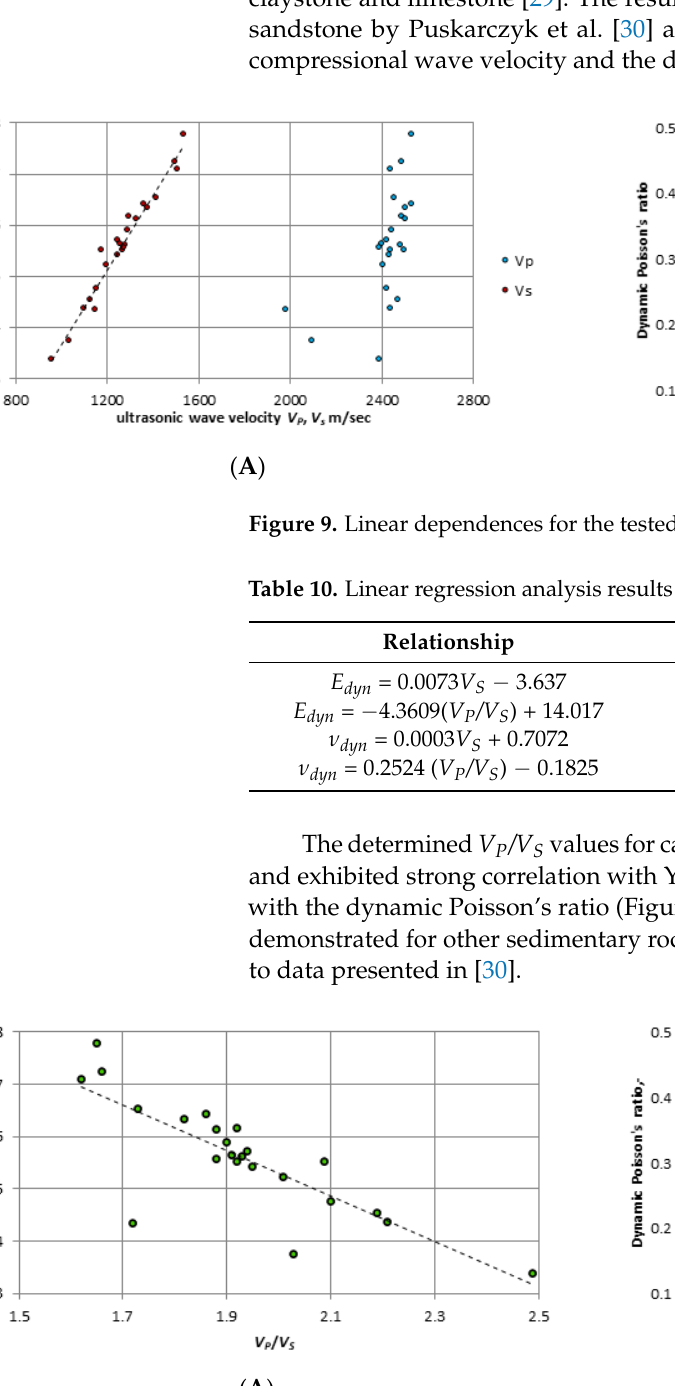
( B ) Figure 11. Static and dynamic values of Young’s modulus ( A ) and Poisson’s ratio ( B ) for coals sam- pled from the same locations in mine workings. The results presented above confirm the point voiced most often by researchers that the values of the dynamic moduli are greater than the static ones [5]. This also concerns materials other than rock, e.g., polymer matrix composite materials [6]. Studies have demonstrated that this is visible in rock characterized, e.g., by low elasticity during static